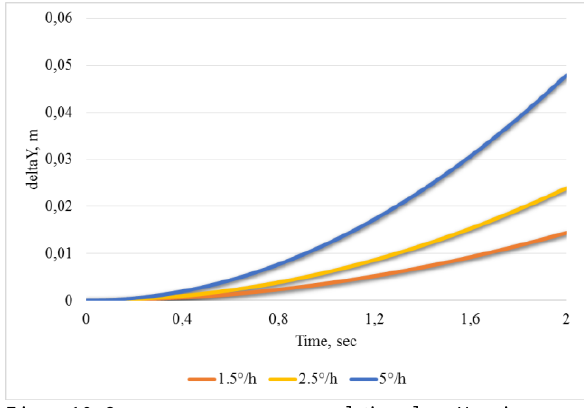
Figure 10. Gyroscopes errors accumulation along Y axis